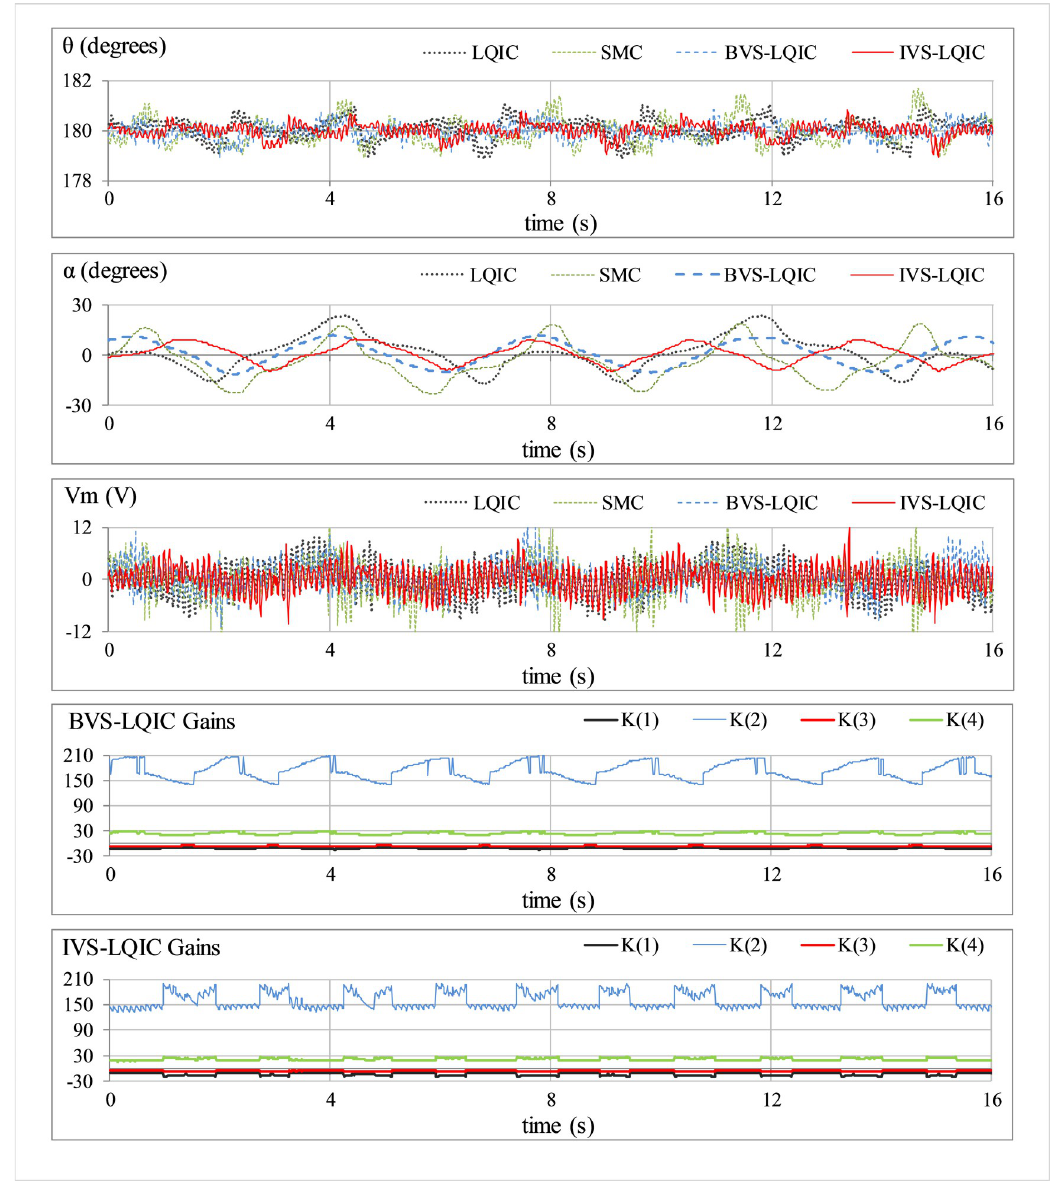
Fig 10. Pendulum’s response under sinusoidal